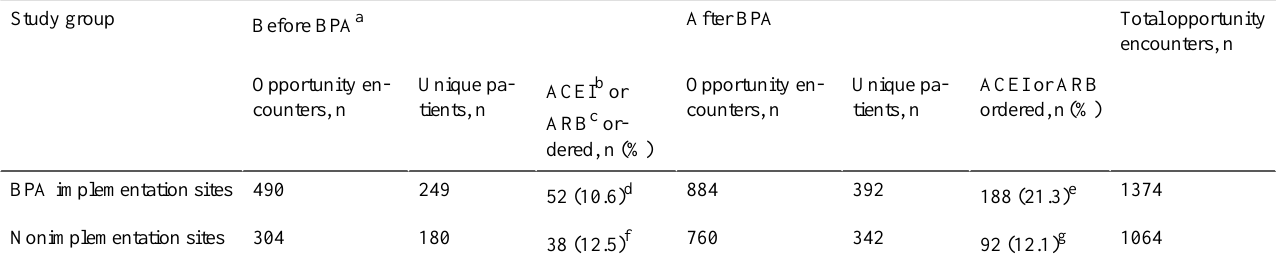
Table 1. Description of opportunity encounters in Best Practice Advisory implementation and nonimplementation sites before and after the implementation of Best Practice Advisory with a “chart closure” hard